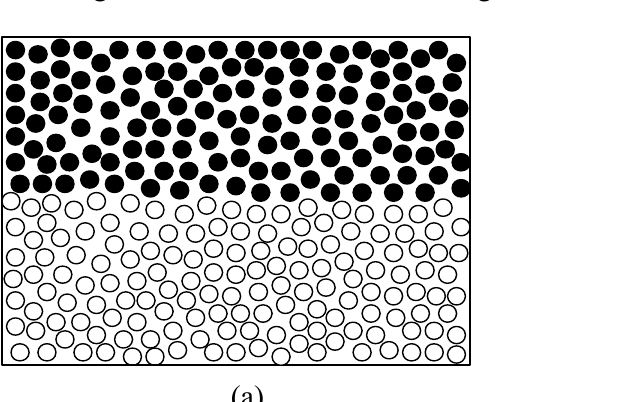
Figure 1. Cartoon illustrating the exchange of molecules across an interface between two different fluids activated by the molecules’ random motion; (a) before starting the exchange, (b) instantaneous state during the